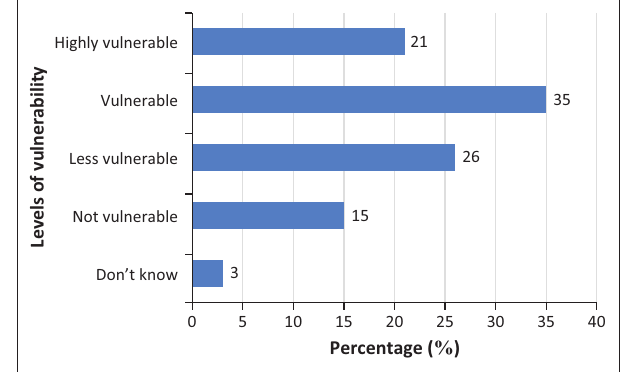
FIGURE 8: Percentage of respondents’ practice of preparedness for flood mitigation measure.